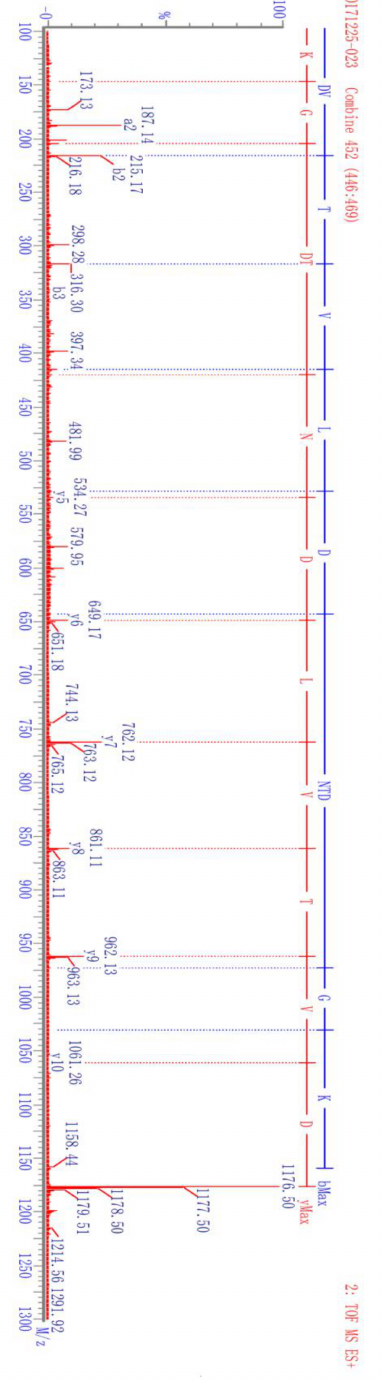
Figure 2. Fragment ions camel lactoferrin signature peptide DVTVLDNTDGK and its corresponding isotope-labeled analog